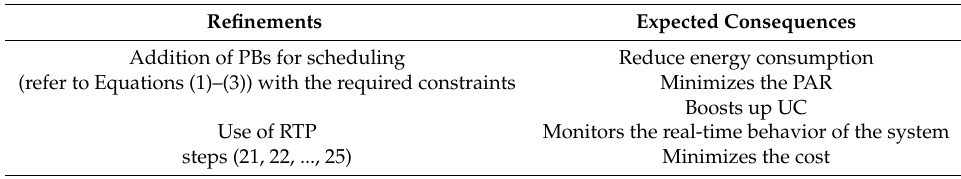
Table 5. Refinements in BPSO.